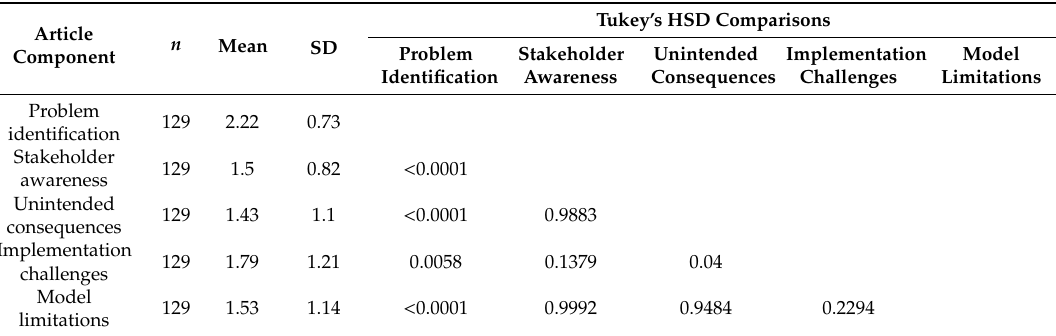
Table 5. Tukey’s HSD comparisons for article and model